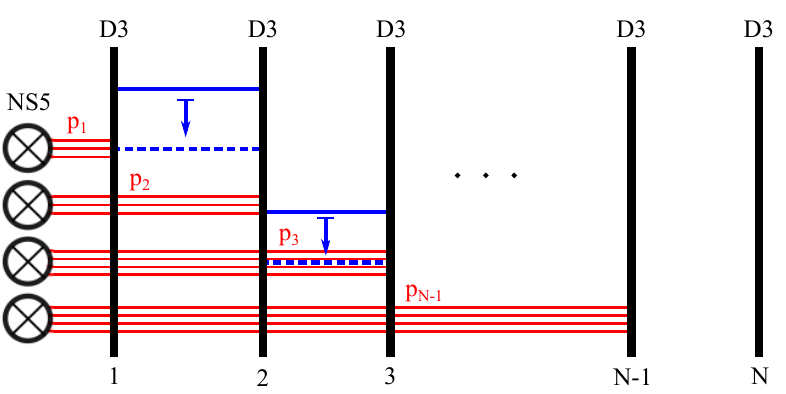
Figure 14 . This (cid:12)gure describes a Hanany-Witten dual frame of the brane con(cid:12)guration in which monopole bubbling is a non-singular process for irreducible ’t Hooft defects. In this (cid:12)gure we can see that bubbling of the (cid:12)nite D1-branes (blue) occur when they become spatially coincident with the NS5-brane (and associated D1-branes in red) in the x 1 ; 2 ; 3 -directions. Here, one can again see that in this duality frame, monopole bubbling is non-singular as it corresponds to at most coincident